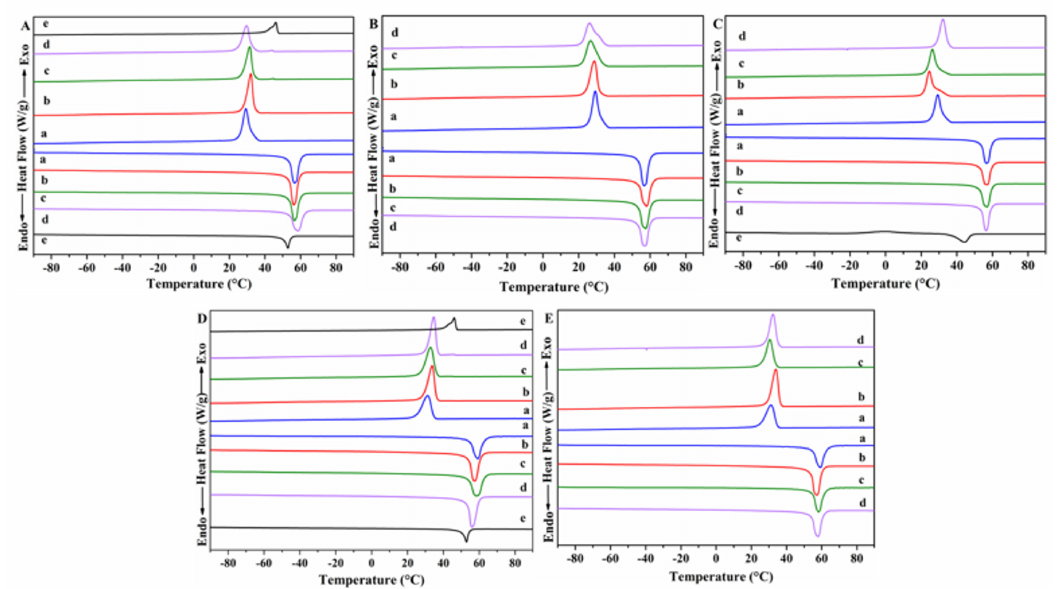
Figure 7. DSC thermograms of: ( A ) solution blended PCL/APIBPOSS; ( B ) solution blended PCL/APIOPOSS; ( C ) solution blended PCL/PIOPOSS-PCL-PIOPOSS; ( D ) melt mixed PCL/APIBPOSS; ( E ) melt mixed PCL/APIOPOSS: ( a ) neat PCL; ( b ) PCL/POSS-2; ( c ) PCL/POSS-5; ( d ) PCL/POSS-10; ( e ) APIBPOSS or